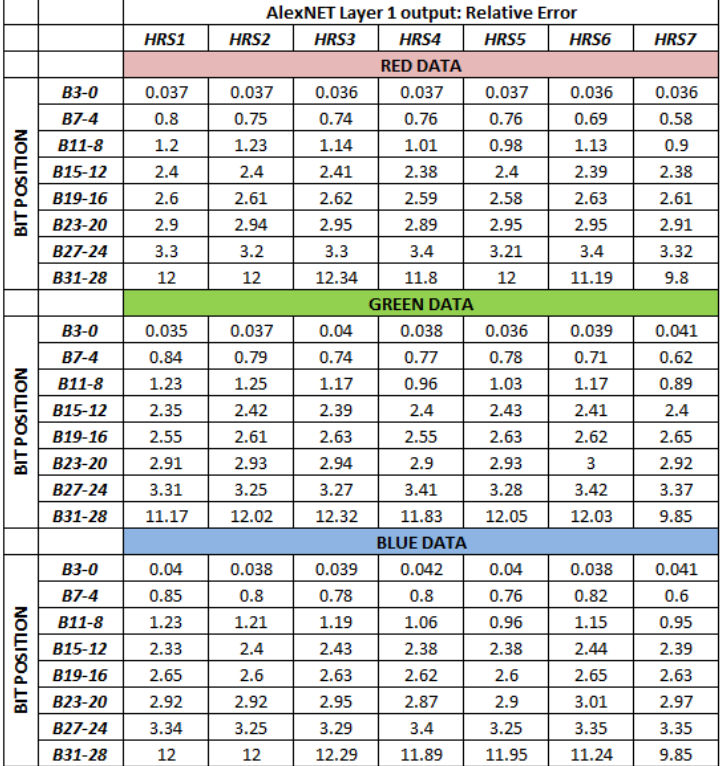
Figure 16. Bitwise relative error for all the 7-HRS values listed for different 4-bit positions along the 32-bit binary representation of the floating-point value for the CNN weights. The error values are listed separately for the red, green and blue colors accordingly .